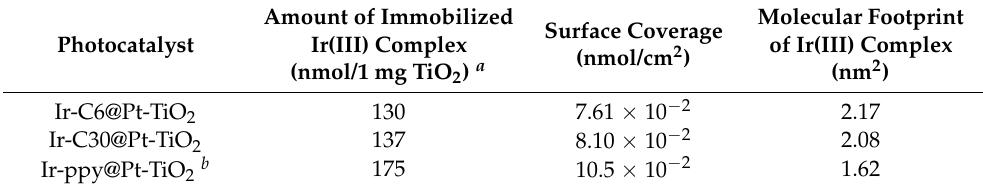
Table 2. Comparison of the immobilized amounts, surface coverage, and molecular footprints of Ir-C6, Ir-C30, and